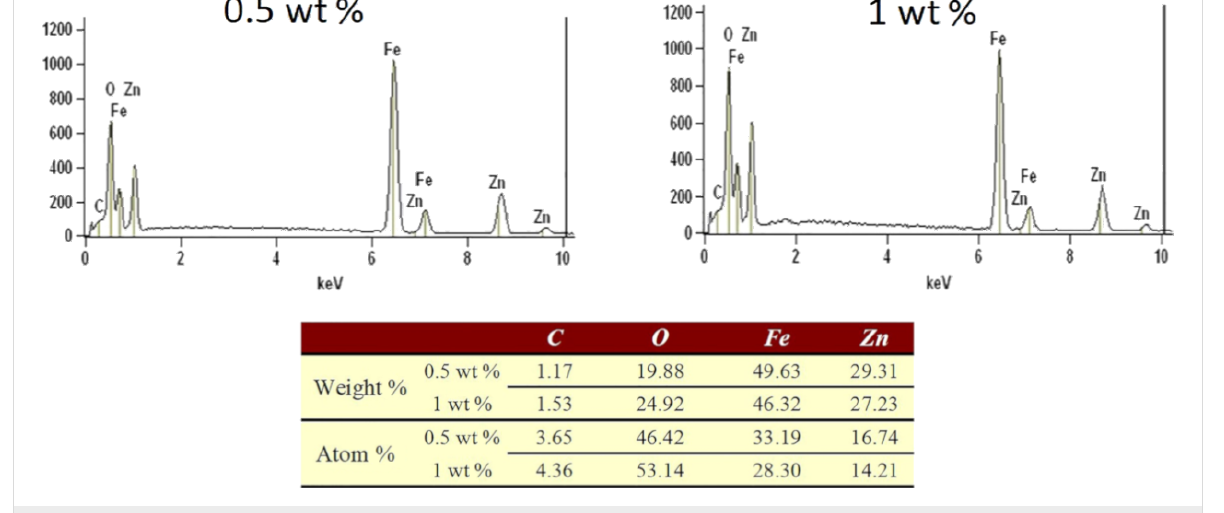
Figure 4: EDX results of the ZnFe 2 O 4 /rGO samples containing 0.5 and 1 wt % rGO.